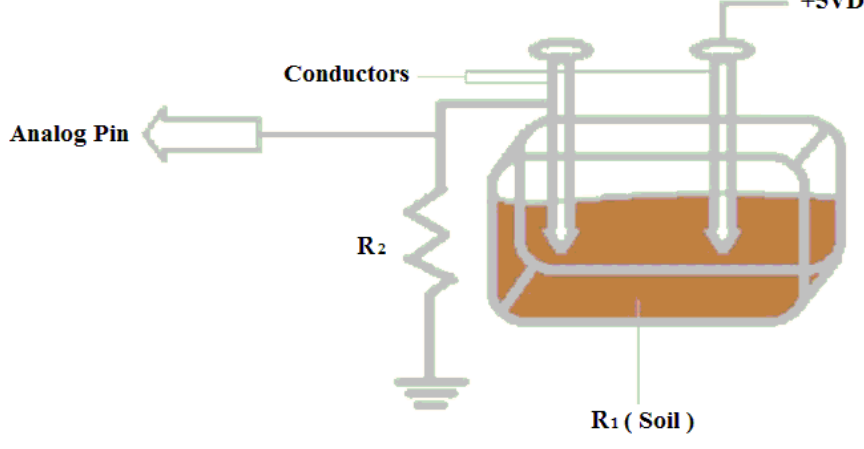
Figure 2. Soil moisture sensor.